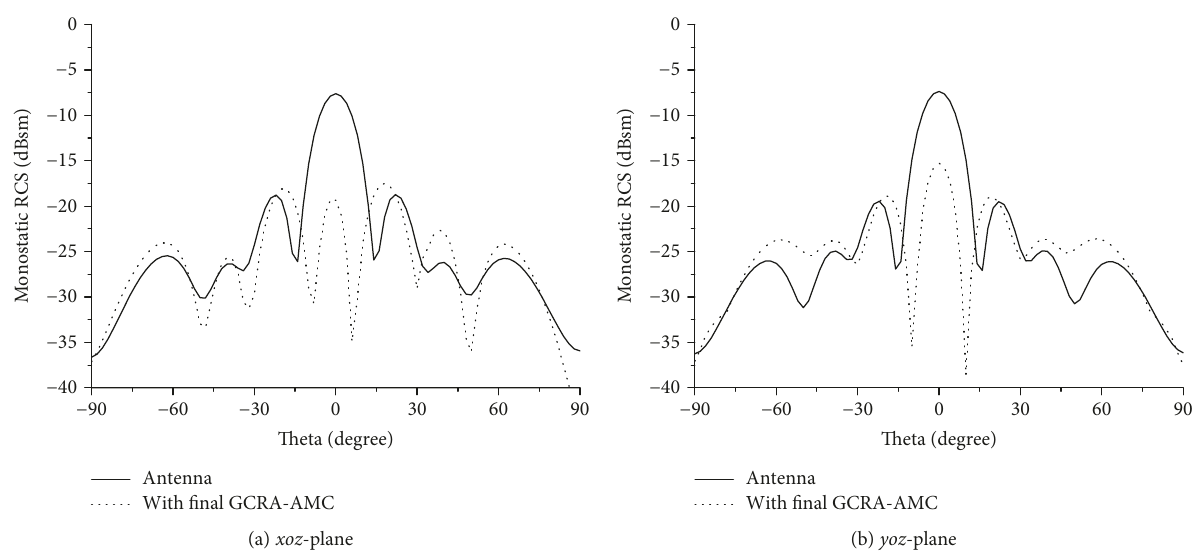
Figure 14: The monostatic RCS of the microstrip antenna with and without fi nal GCRA-AMC under di ff erent incident